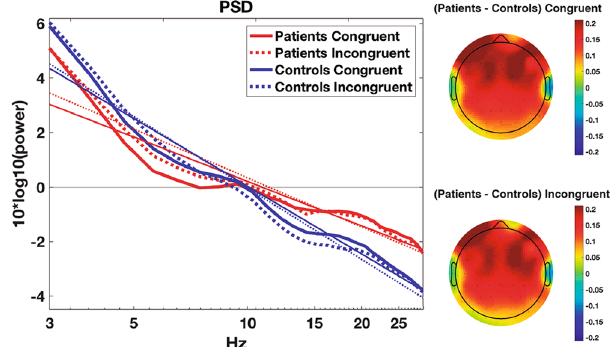
Figure 2. Mean Power Spectral Density (PSD) at all electrodes for each group and condition. Thin lines represent the least squares regression. Topographies show the difference in slope between groups for each condition. As may be seen, the difference between groups in slopes is more evident at frontal